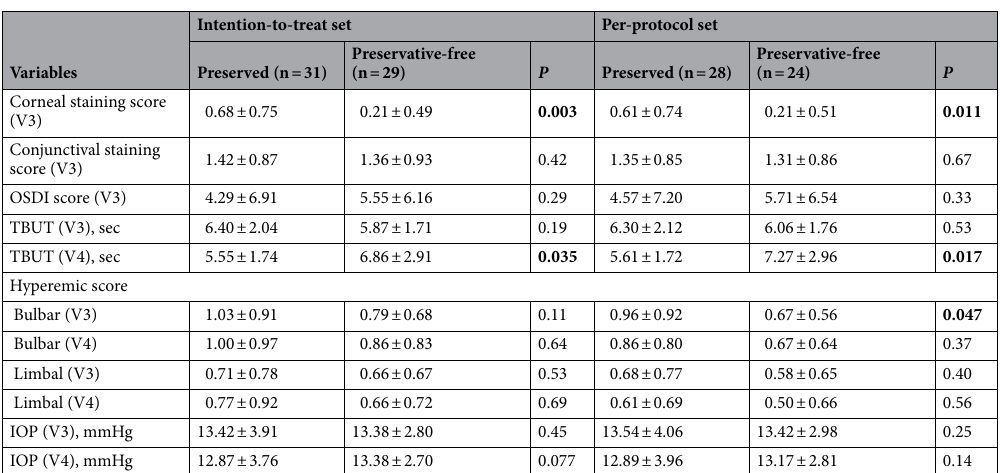
Table 3. Secondary outcome measurement at 4-week visit (V3) and 12-week visit (V4). OSDI ocular surface disease index, TBUT tear-film break up time, IOP intraocular pressure. Comparative analyses were performed using ANCOVA after adjusting IOP, age, central corneal thickness, and baseline data. Significant values with P < 0.05 are indicated in bold.